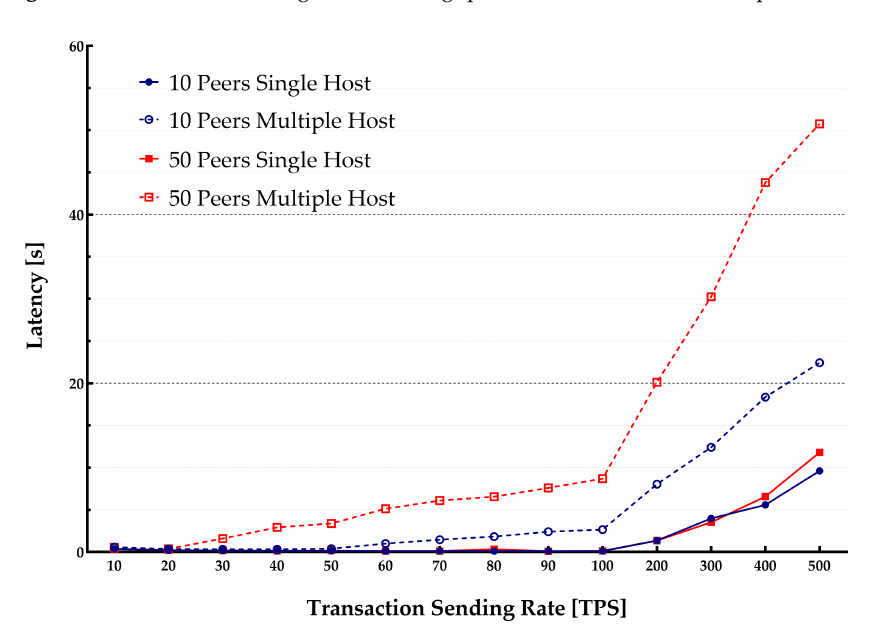
Figure 10. Transactions sending rate vs latency for various endorsement